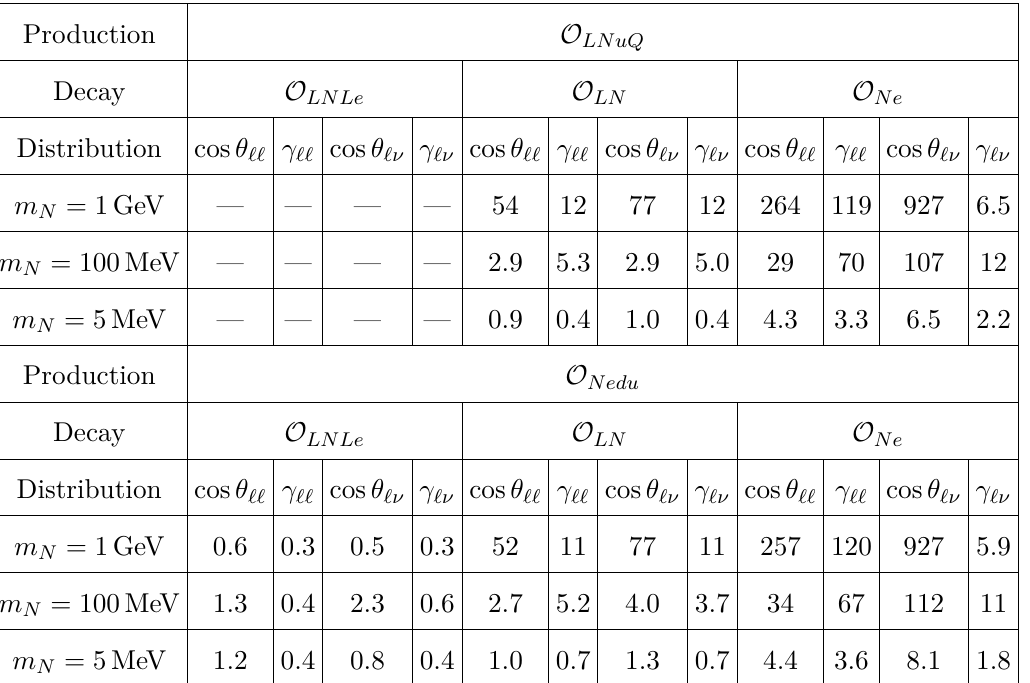
Table 9 . Determining the production and decay operators using ¯ N decay. χ 2 decay with different production and decay operators. Here, the RHN is a Dirac fermion and is produced (decays) via O LNuQ ( O LNLe